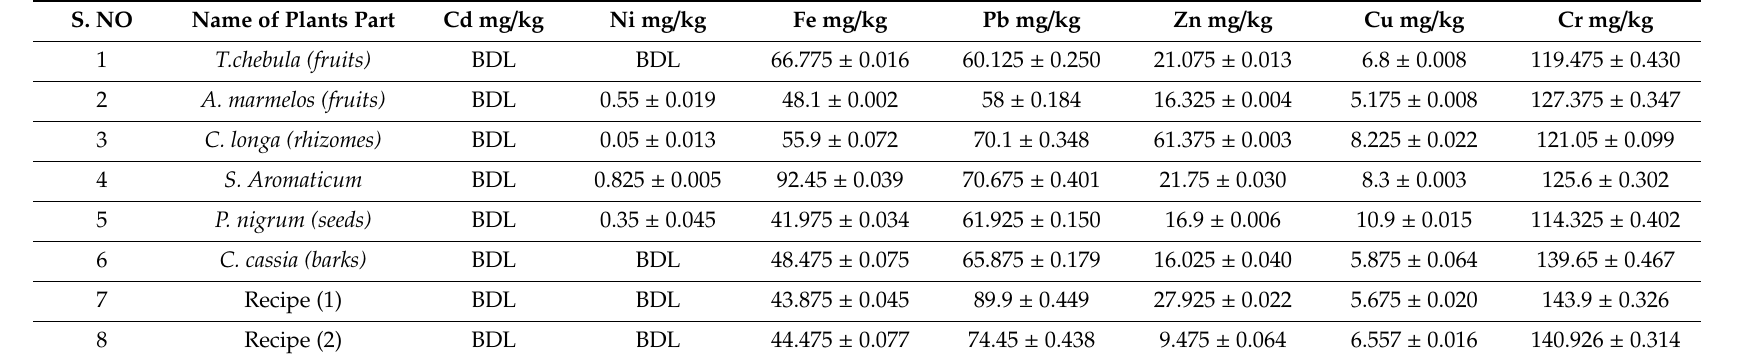
Table 3. Metals in herbal plants and their recipes e.g., Cd, Ni, Fe, Pb, Zn, Cu and